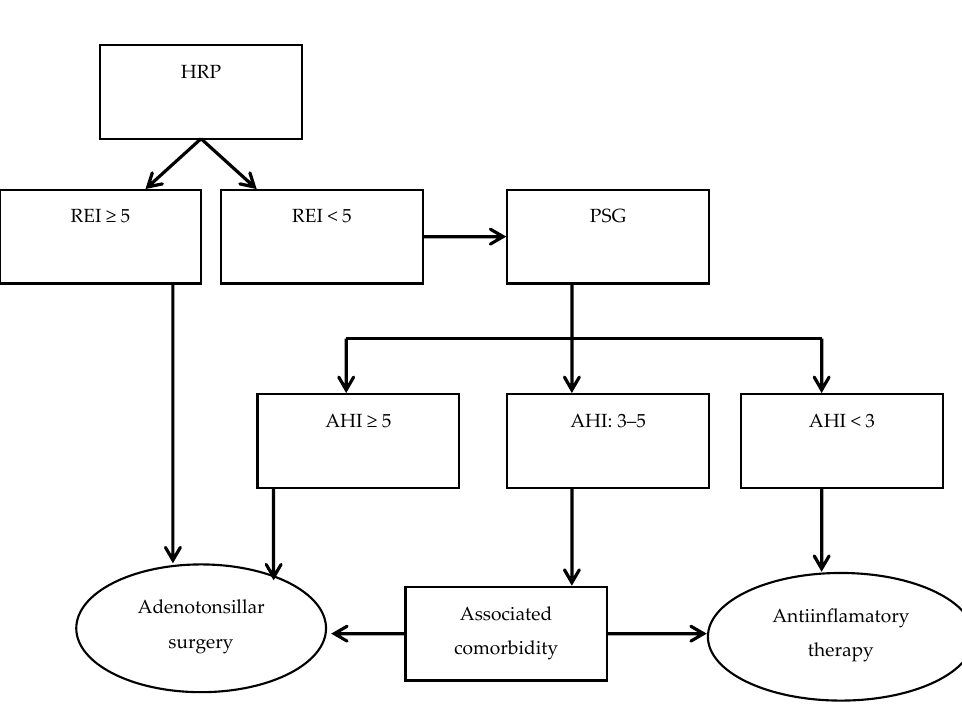
Figure A1. Indications for orthodontist evaluation and treatment or CPAP based on current guidelines and clinical criteria (47).